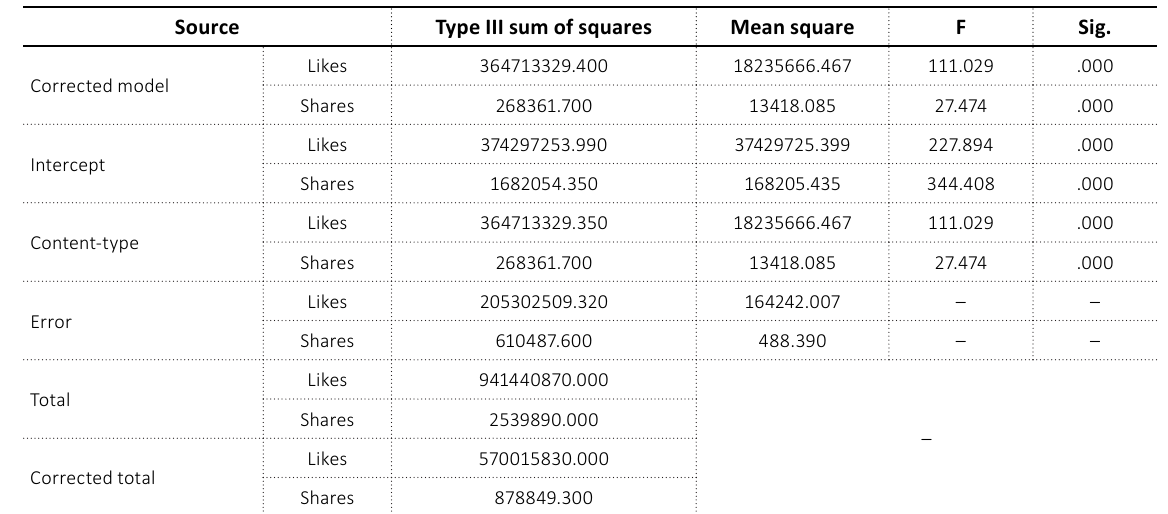
Table 7. Statistical significance of